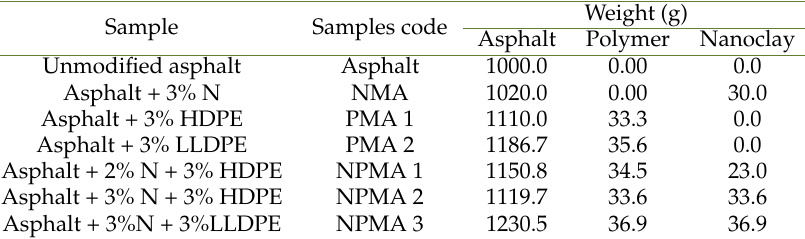
Table 3. Modified asphalt binders’ weight and code